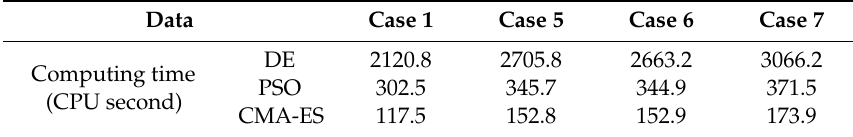
Table 4. Computing time of evolutionary computation methods.